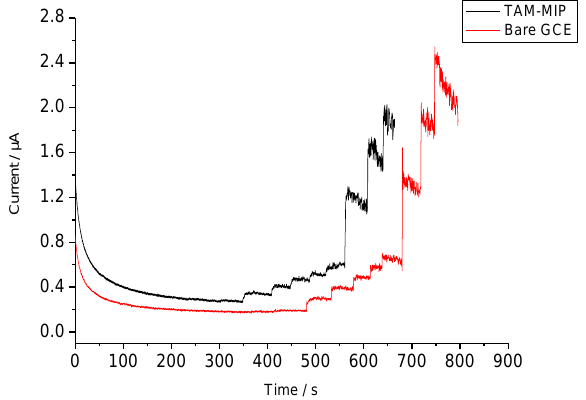
Figure 5. Amperometric responses of bare GCE (red) and TAM-MIP (black) on stepwise addition of 5 × 1 and 3 × 10 µM TAM on different electrodes in 85 mM acetate buffer containing 15% methanol at pH